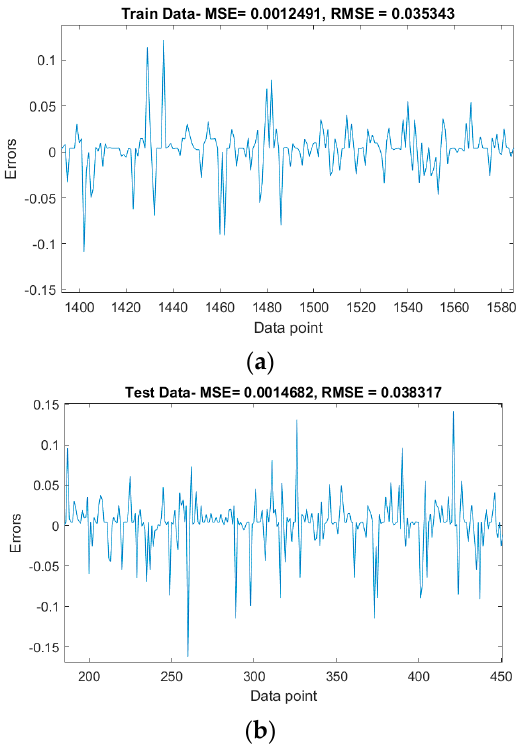
Figure 9. ( a ) Training errors, and ( b ) testing errors for the special interval.